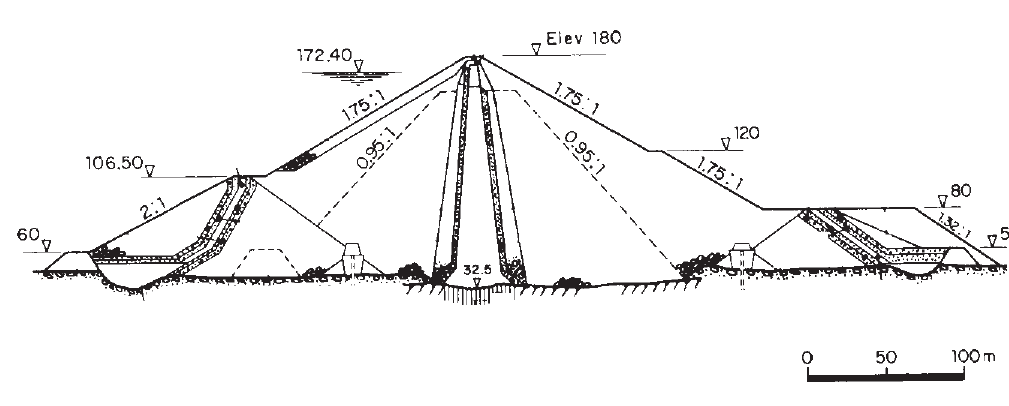
Fig. 6. Main cross section of El Infiernillo